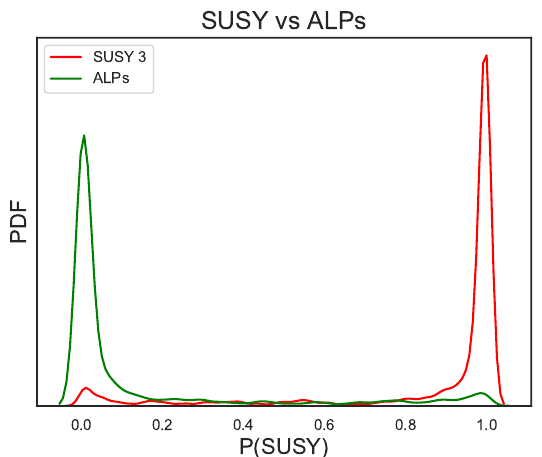
Figure 14: Classifier output P(SUSY) from the DNN run for monojet SUSY3 and ALP with r = 20.